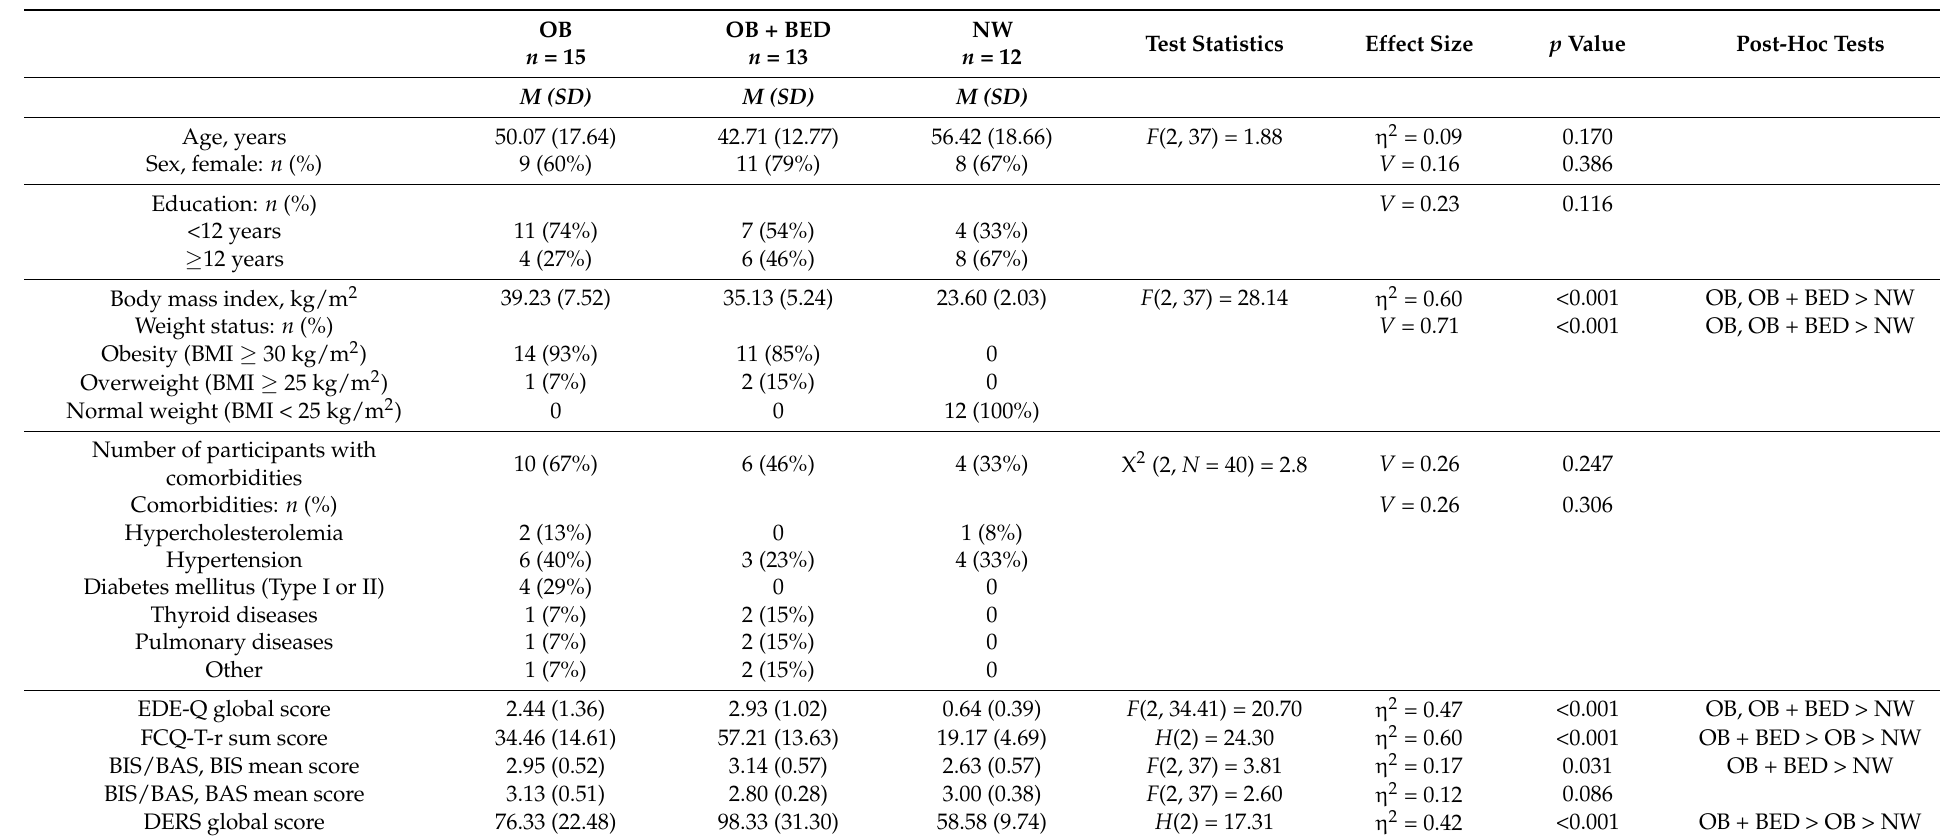
Table 1. Participants’ sociodemographic and clinical characteristics at the first